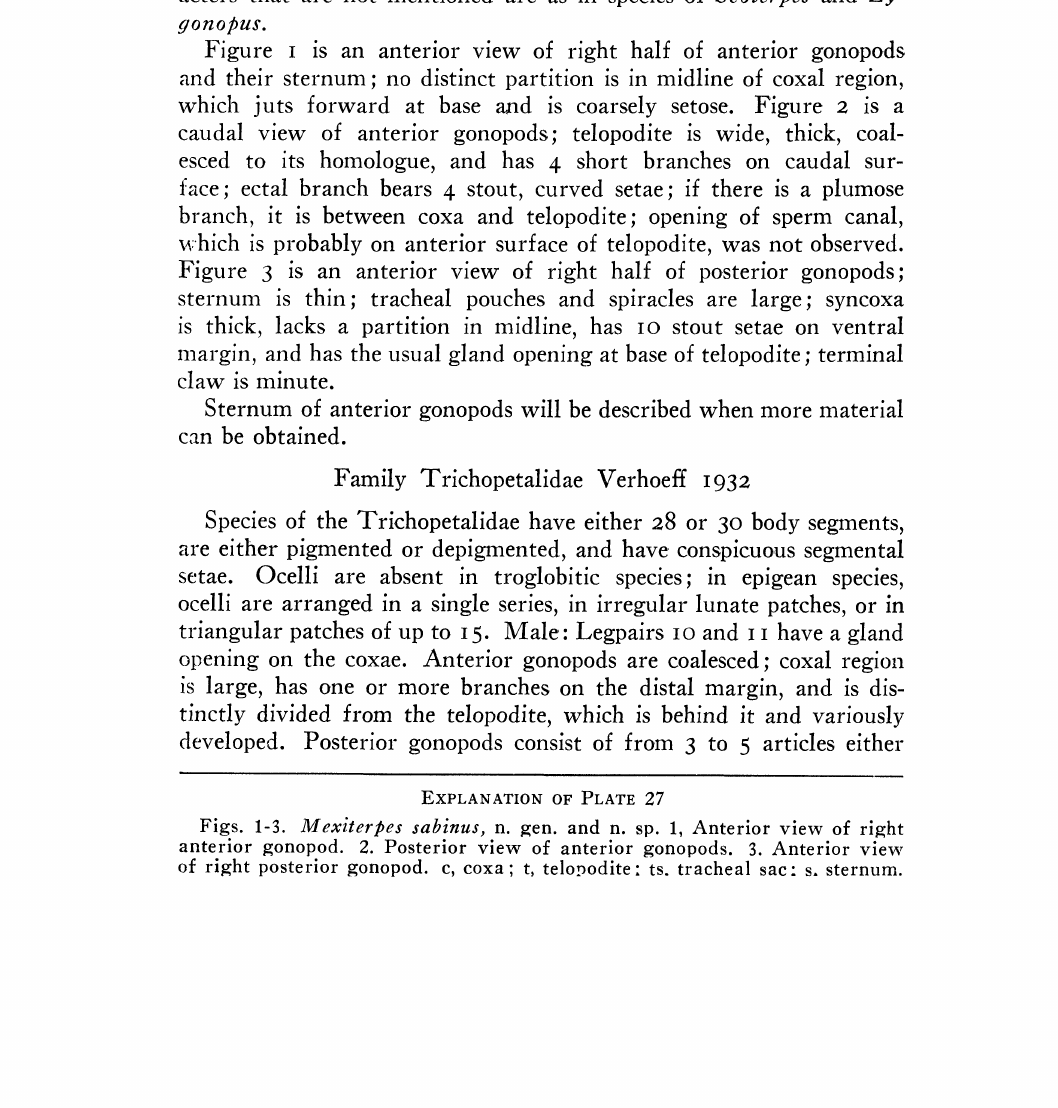
Figure is an anterior view of right half of anterior gonopods and their sternum; no distinct partition is in midline o coxal region, which juts forward at base and is coarsely setose. Figure 2 is a caudal view of anterior gonopods; telopodite is wide, thick, coal- esced to its homologue, and has short branches on caudal sur- face; ectal branch bears stout, curved setae; if there is a plumose branch, it is between coxa and telopodite; opening of sperm canal, which is probably on anterior surface of telopodite, was not observed. Figure 3 is an anterior view of right half of posterior gonopods; sternum is thin; tracheal pouches and spiracles are large; syncoxa is thick, lacks a partition in midline, has IO stout setae on ventral margin, and has the usual gland opening at base of telopodite; terminal claw is minute.